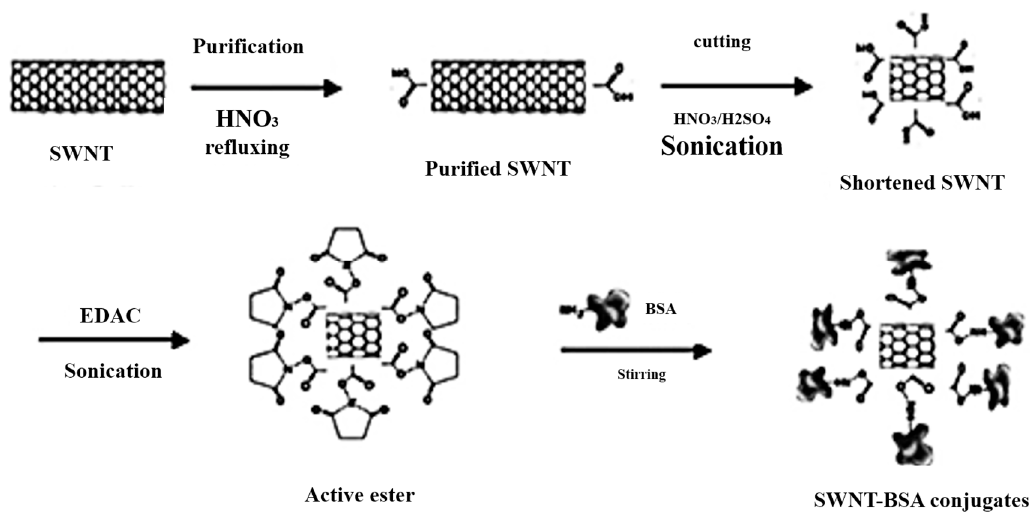
Figure 8. Representative scheme for the preparation of SWCNTs-BSA “Reproduced with permission from Weng et al. [60]. Copyright Wiley, 2007”.